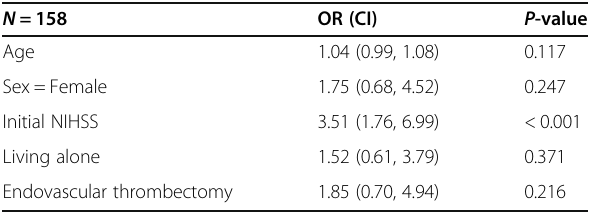
Table 3 Factors predicting membership of the severely compared to moderately affected